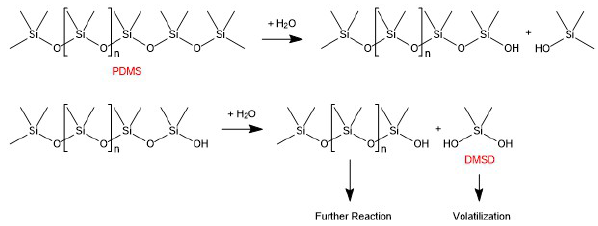
Figure 5. Proposed mechanism for the formation of DMSD from the hydrolysis of PDMS.